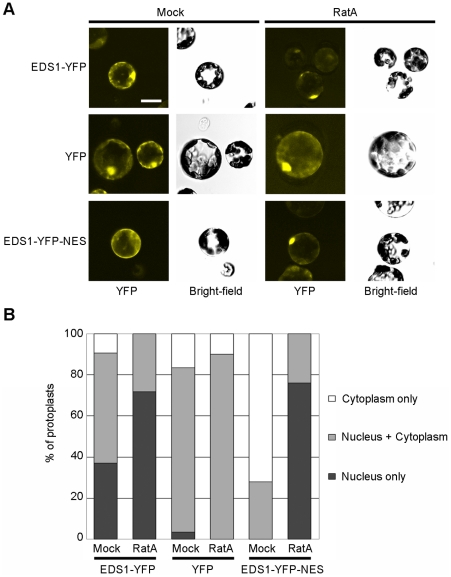
EDS1-YFP shuttles from the nucleus to the cytoplasm in Arabidopsis protoplasts.(A) YFP fluorescence and bright-field images of Arabidopsis protoplasts from stable transgenic lines, as indicated, 4 h after treatment with 15 ng/ml of Ratjadone A (RatA) or methanol (Mock). Bar is 10 µm. (B) Percentage of protoplasts showing fluorescence only in the nucleus, only in the cytoplasm or in both compartments determined by counting at least 50 protoplasts per treatment. The experiment was performed three times with similar results.